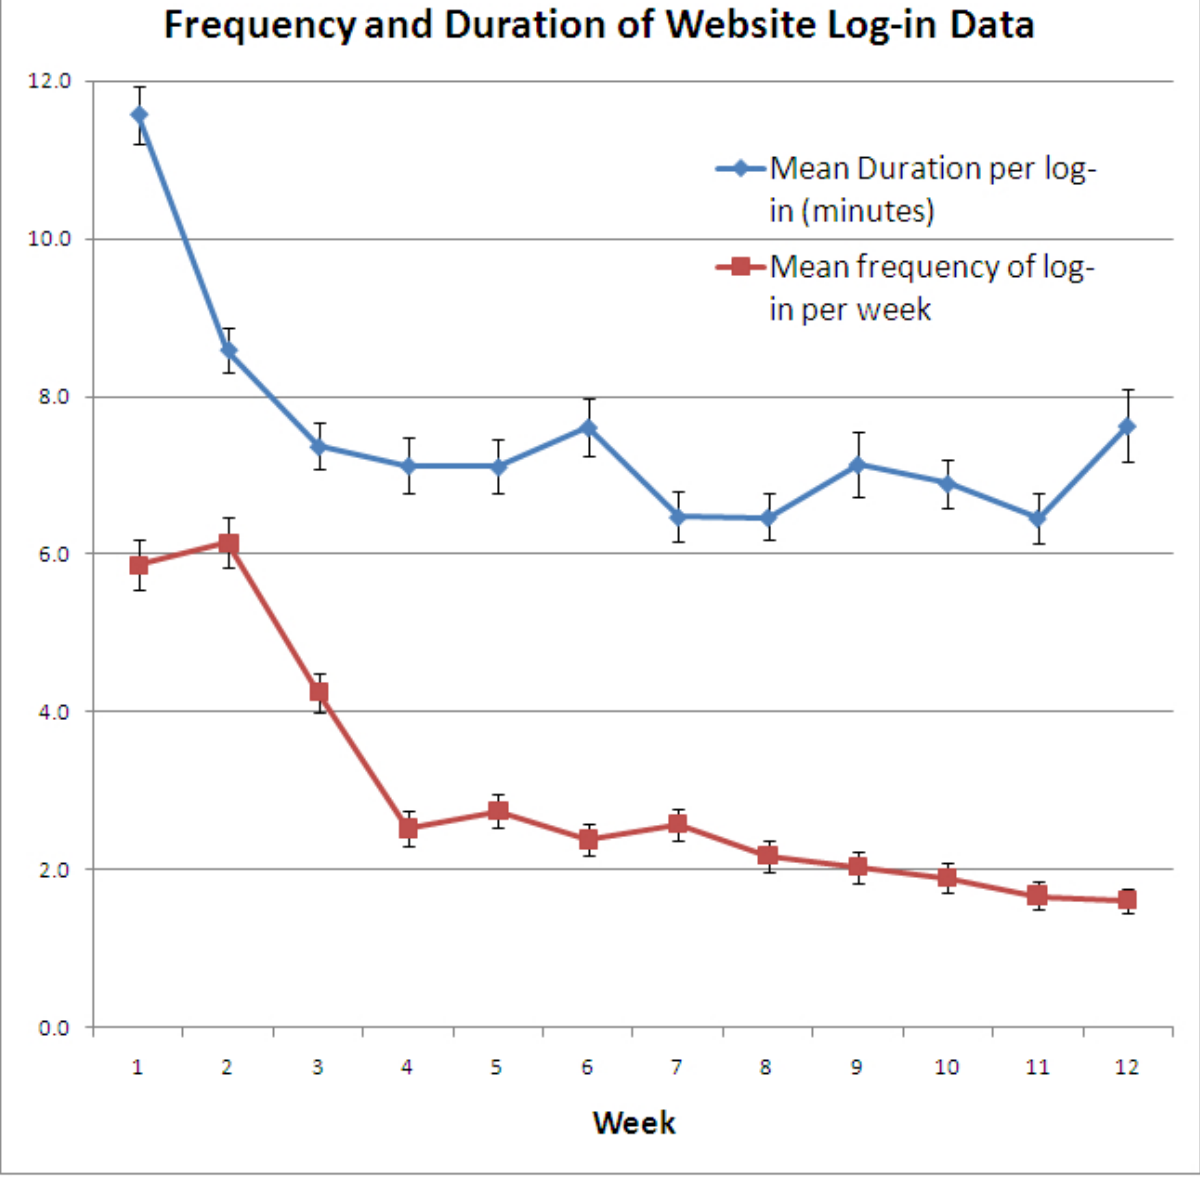
Figure 4. Mean website log-in duration and frequency throughout the study period (Data points are means with standard error and are presented for all employees as there was no significant difference between the sites based on